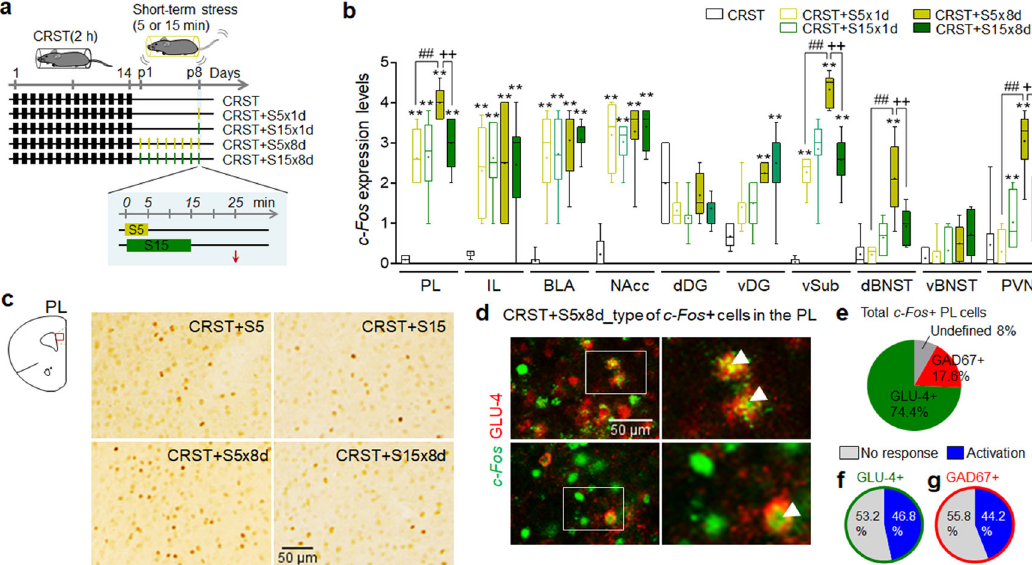
Fig. 4 Repeated treatment with short-term behavioral stress recruits the brain regions regulating stress coping in CRST mice. a Experimental design. CRST mice were treated with a single 5-min or 15-min restraint (S5 × 1d and S15 × 1d, respectively) on post-stress day 8, and then sacri fi ced 20 min and 10 min later, respectively. Another group of CRST mice was treated with 5-min or 15-min restraint for 8 days (S5 × 8d and S15 × 8d, respectively), and then sacri fi ced, respectively, 20 min and 10 min after the last restraint. The red arrow ( ↓ ), sample prep point. b , c Quanti fi cation of c-Fos expression levels in the PL, IL, BLA, NAcc, dorsal dentate gyrus (dDG), ventral dentate gyrus (vDG), vSub, dBNST, vBNST, and PVN ( b ). Photomicrographs showing c-Fos expression in the PL (red box) (C) of the S5 × 1d, S15 × 1d, S5 × 8d, and S15 × 8d groups ( n = 4 – 6 animals per group). d – g Photomicrographs showing c-Fos induction in GLU-4-positive or GAD67-positive neurons in the PL ( d ), and their quanti fi cation levels ( e – g ) ( n = 6 animals for a group). The details for c-Fos mapping are shown in Supplementary Data 1. Data were mean ± SEM. Gray circles represent individual data points. *, **, the difference compared to control; #, the difference compared to CRST; + , the difference between indicated groups. **, ##, ++ , p < 0.01 (one-way ANOVA followed by Newman – Keuls post hoc test). See Supplementary Data 4 for statistical